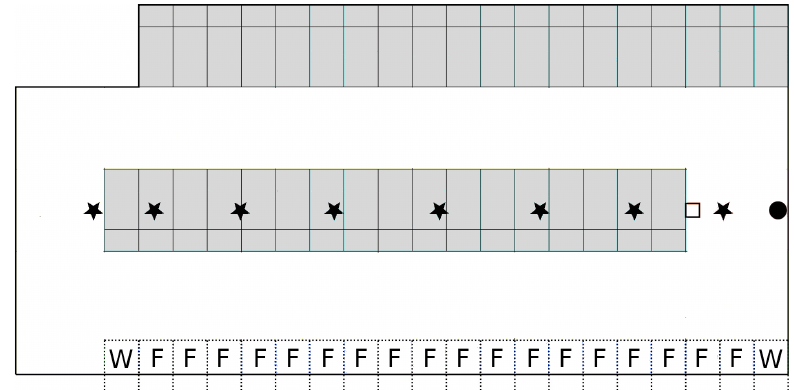
Figure 1. Schematic representation of the barn. The lying cubicles were highlighted grey. The water and feeding troughs are denoted with ‘W’ and ‘F’, respectively. The camera positions are marked by black stars. The licking stone and the cow brush are depicted as white square and black dot,